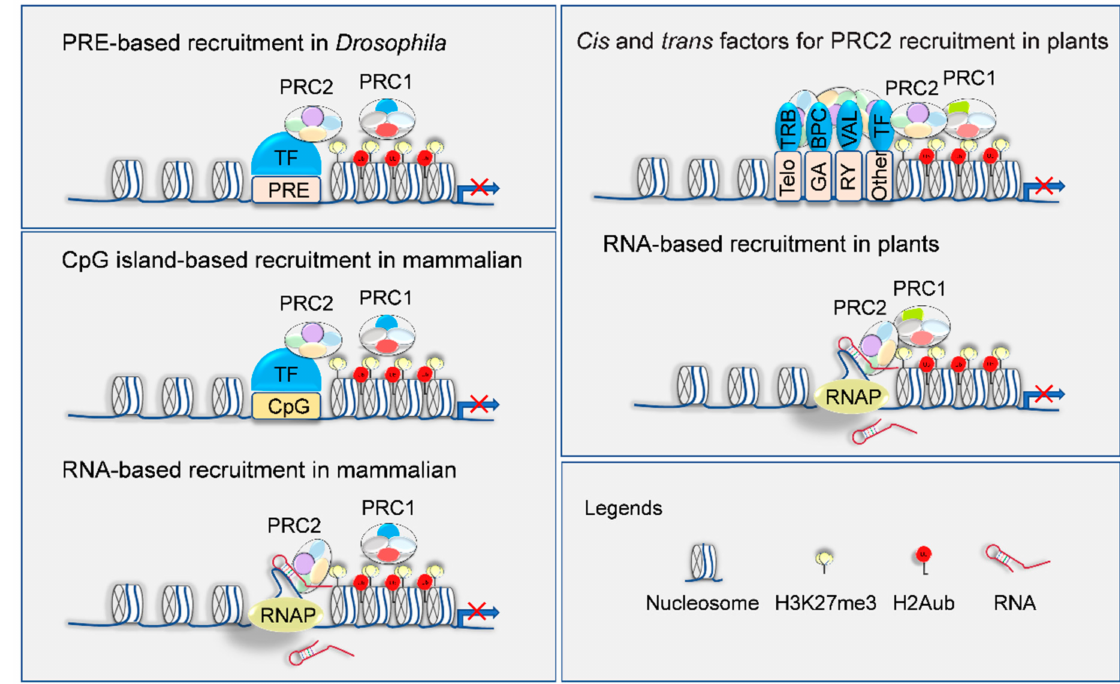
Figure 2. Targeting mechanisms of H3K27me3 deposition on a genome. Diagram shows PRE in the recruitment of PRC2 to target loci in Drosophila , CpG-island-, and RNA-based PRC2 recruitment in mammalian species, as well as cis - and trans -acting factors involved in PRC2 recruitment in plants. TF, trans -acting factor; RNAP, RNA polymerase. Details are explained in the